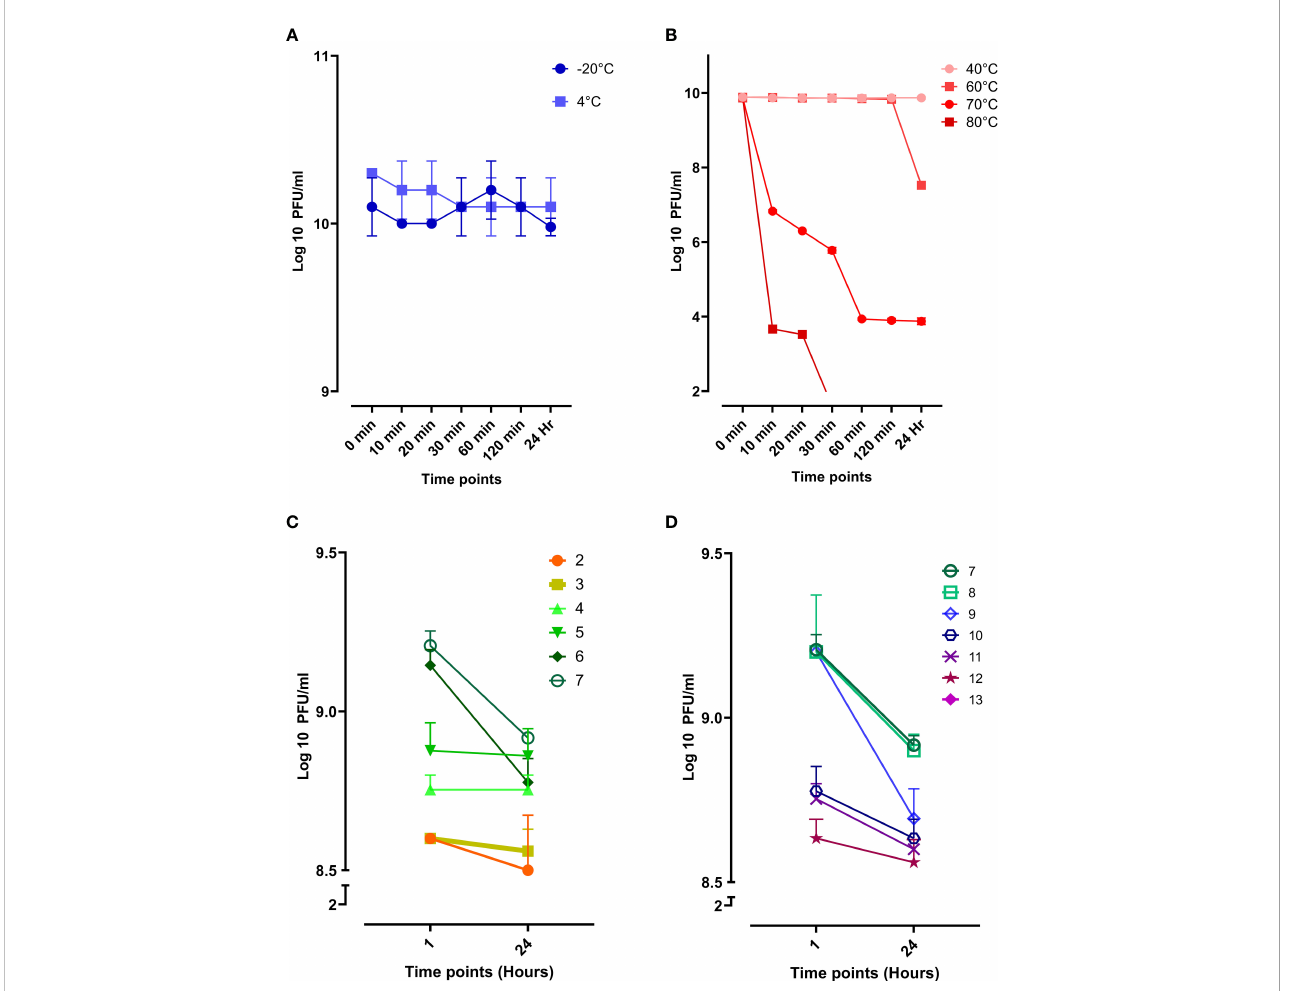
FIGURE 5 Stability of phage vB_Kpn_ZCKp20p at different temperatures and pH values. (A) Storage temperatures of 20°C and 4°C are represented in blue and light blue, respectively. (B) Phage stability at different thermal temperatures, represented in a red hue (80°C, dark red to 40°C, light red). (C) Phage stability in the acidic spectrum from pH 2 to 7. (D) Phage stability in the alkaline spectrum from pH 7 to 13; At pH 13, no survived phages were detected. The results were plotted as the mean of triplicates with error bars of ±